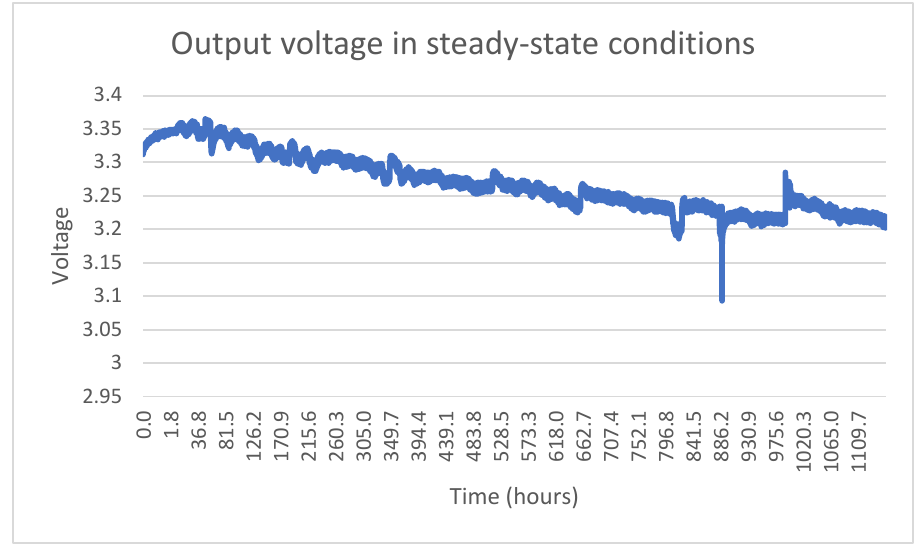
Figure 8. Fuel cell output voltage as a function of time.